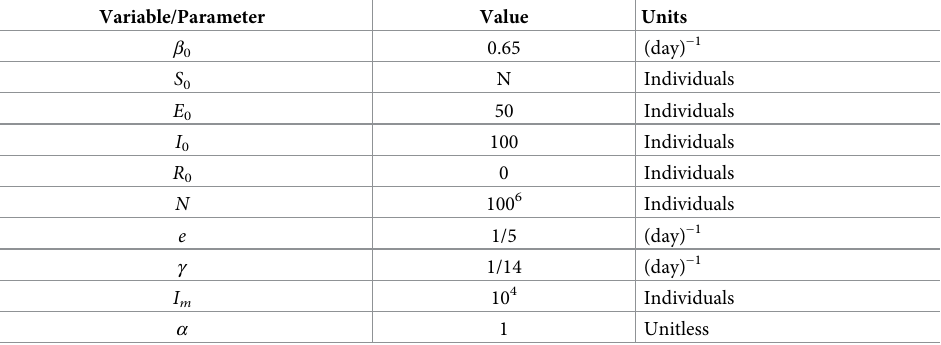
Table 2. Initial conditions and parameter values and their units, for the simulations in Figs 1–6.